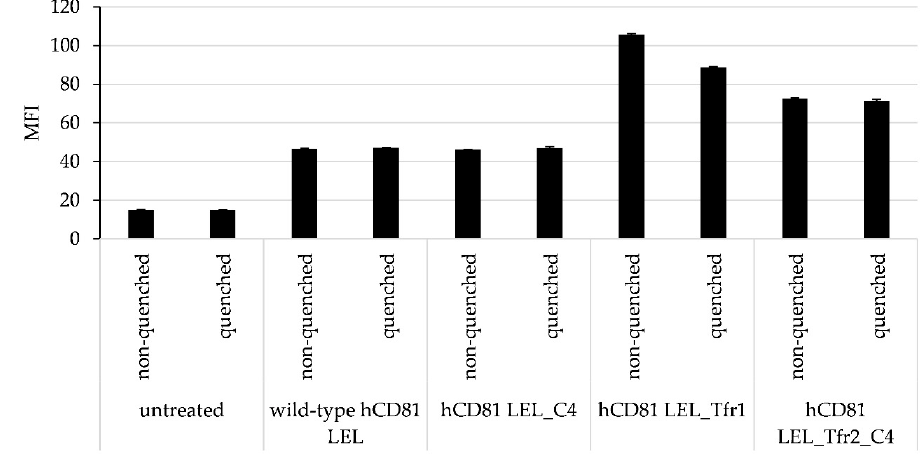
Figure 6. Enhanced internalization of anti-hTfr peptide-engrafted mutants of hCD81 LEL into the target-positive cell line SK-BR3.